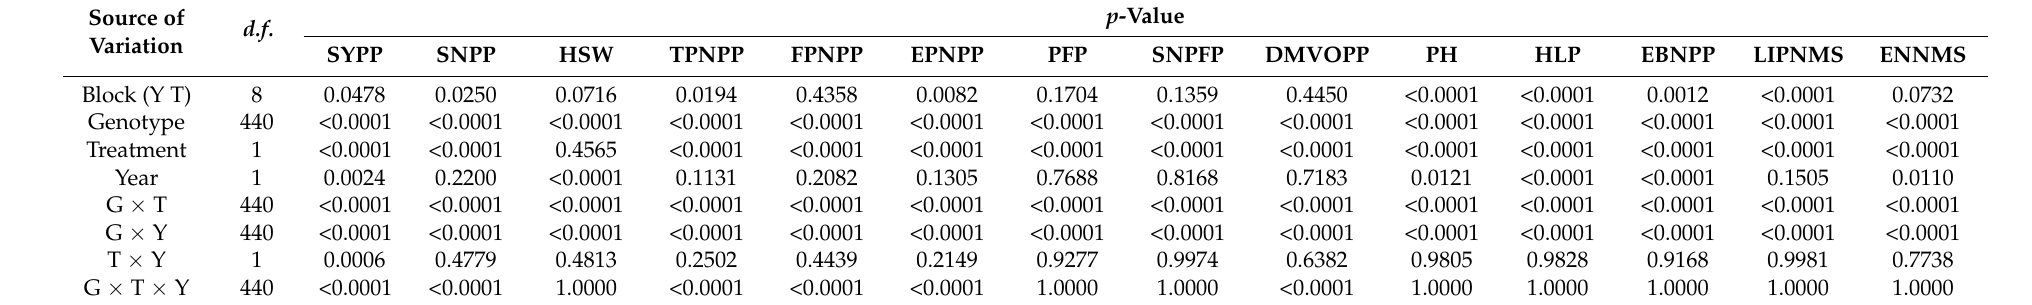
Table 2. Analysis of variance for the 14 traits potentially related to AR tolerance for the tested soybean